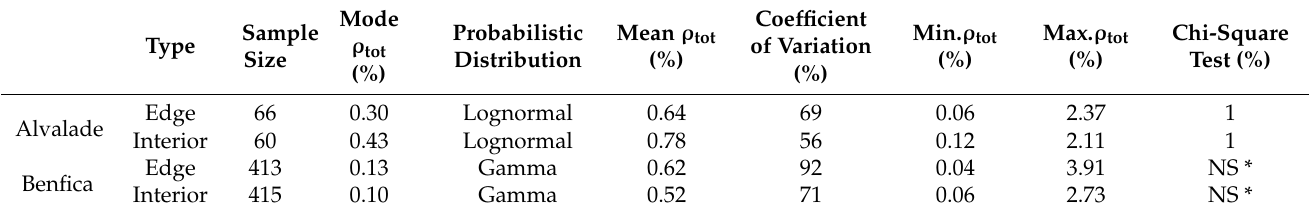
Table 13. Probabilistic distribution of RC beams′ longitudinal reinforcement ratio for each parish.